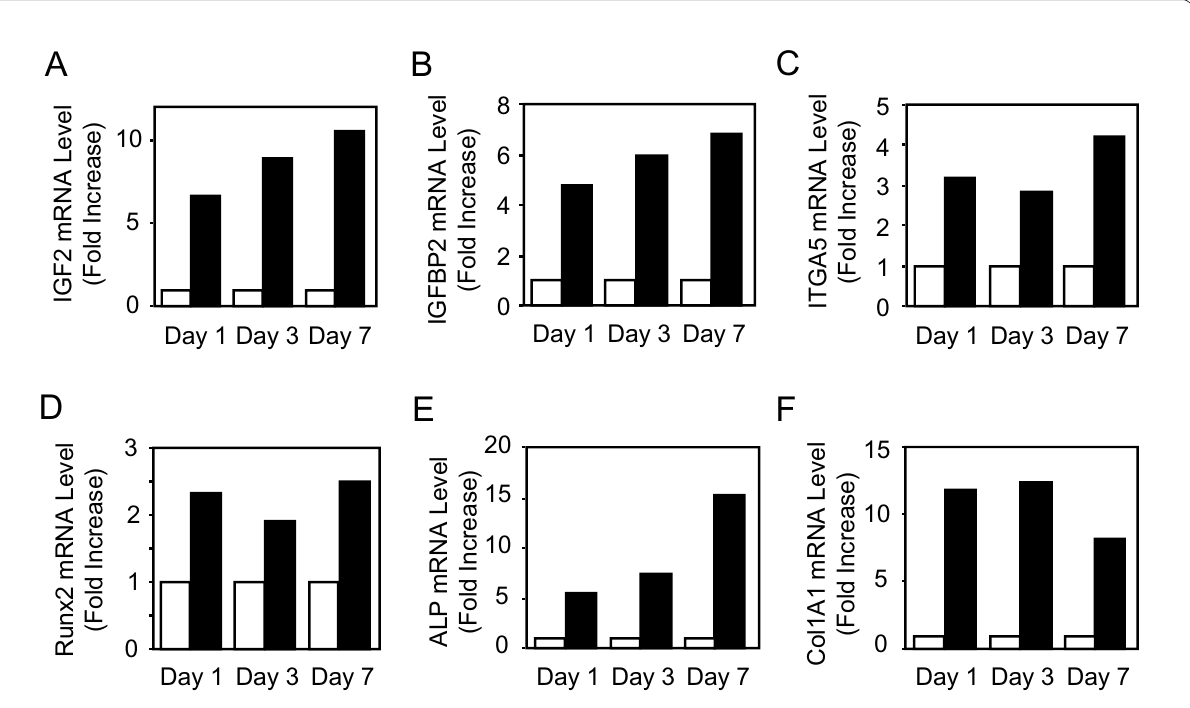
Figure 2 Coordinated Upregulation of IGF2, IGFBP2 and ITGA5 During Osteoblast Differentiation in hMSCs . Adult hMSCs were treated with (black boxes) or without (white boxes) dexamethasone (10 -7 M) to induce osteoblastic differentiation and total RNA was analysed using TaqMan Low- Density Array. IGF2, IGFBP2 and ITGA5 mRNA levels were increased by more than 2-fold in dexamethasone-treated MSCs compared to control cells ( A-C ). This was associated with increased expression of the osteoblast phenotypic genes Runx2, ALP and Col1A1 ( D-F ). Results are expressed as fold increase compared to untreated cells, after normalization to 18 S expression. The data are representative of two separate experiments using mRNA from two different